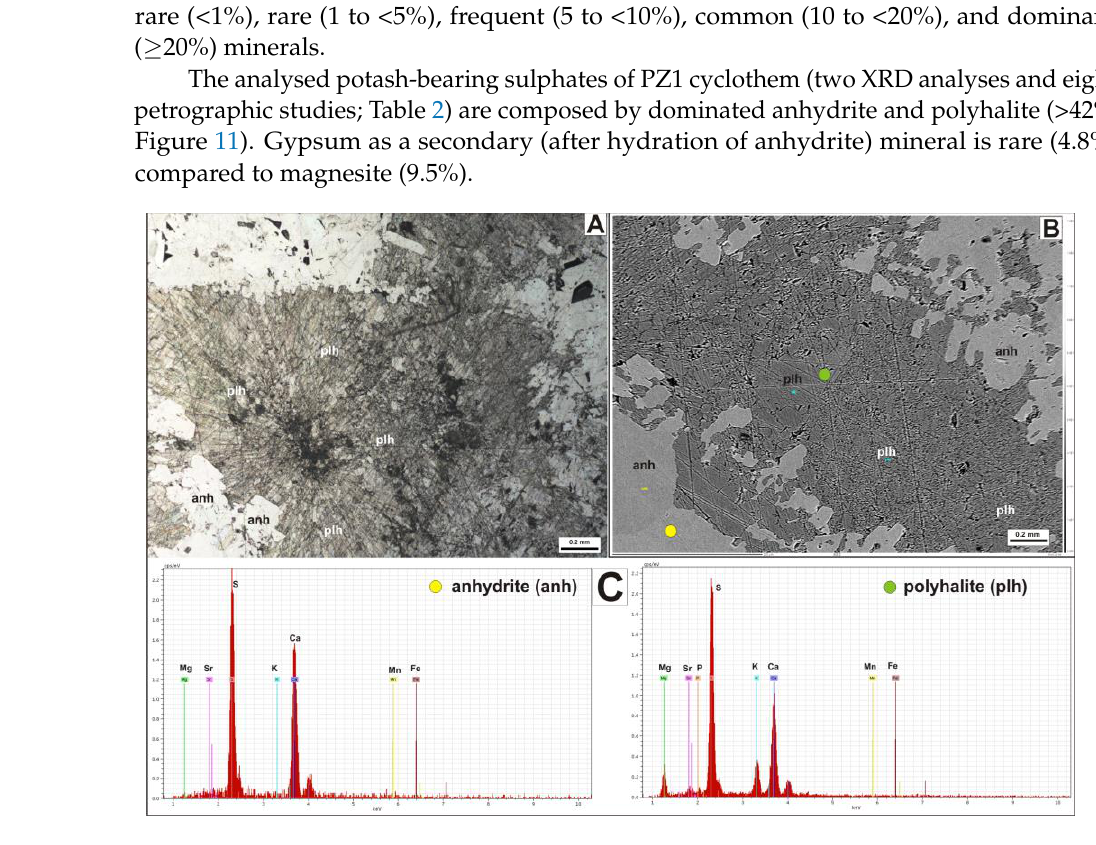
Figure 11. Thin section study, Mieroszyno M-9 borehole, sample M-9/2, depth 770.72 m. Sample location on Fig. 2. ( A ) Radial and tabular crystals of polyhalite (plh, grey) and anhydrite plates (anh, white), microscope image (II polars). ( B ) SEM image of analysed anhydrite and polyhalite crystals with microprobe results; ( C ) colour dots—analytic points. The analysed potash-bearing deposits of PZ2 cyclothem (28 XRD analyses and 14 petrographic studies supplemented with archive data of four thin sections) contain (Ta- ble 4) common minerals (frequency 10–18%), such as: halite (Figure 12A,C), sylvite (Fig- ure 12F), kieserite (Figure 12C,D), and anhydrite (Figure 12E). The frequent (6–8%) ones